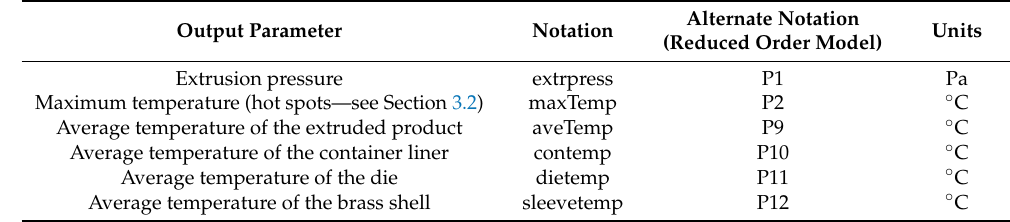
Table 3. Output parameters.